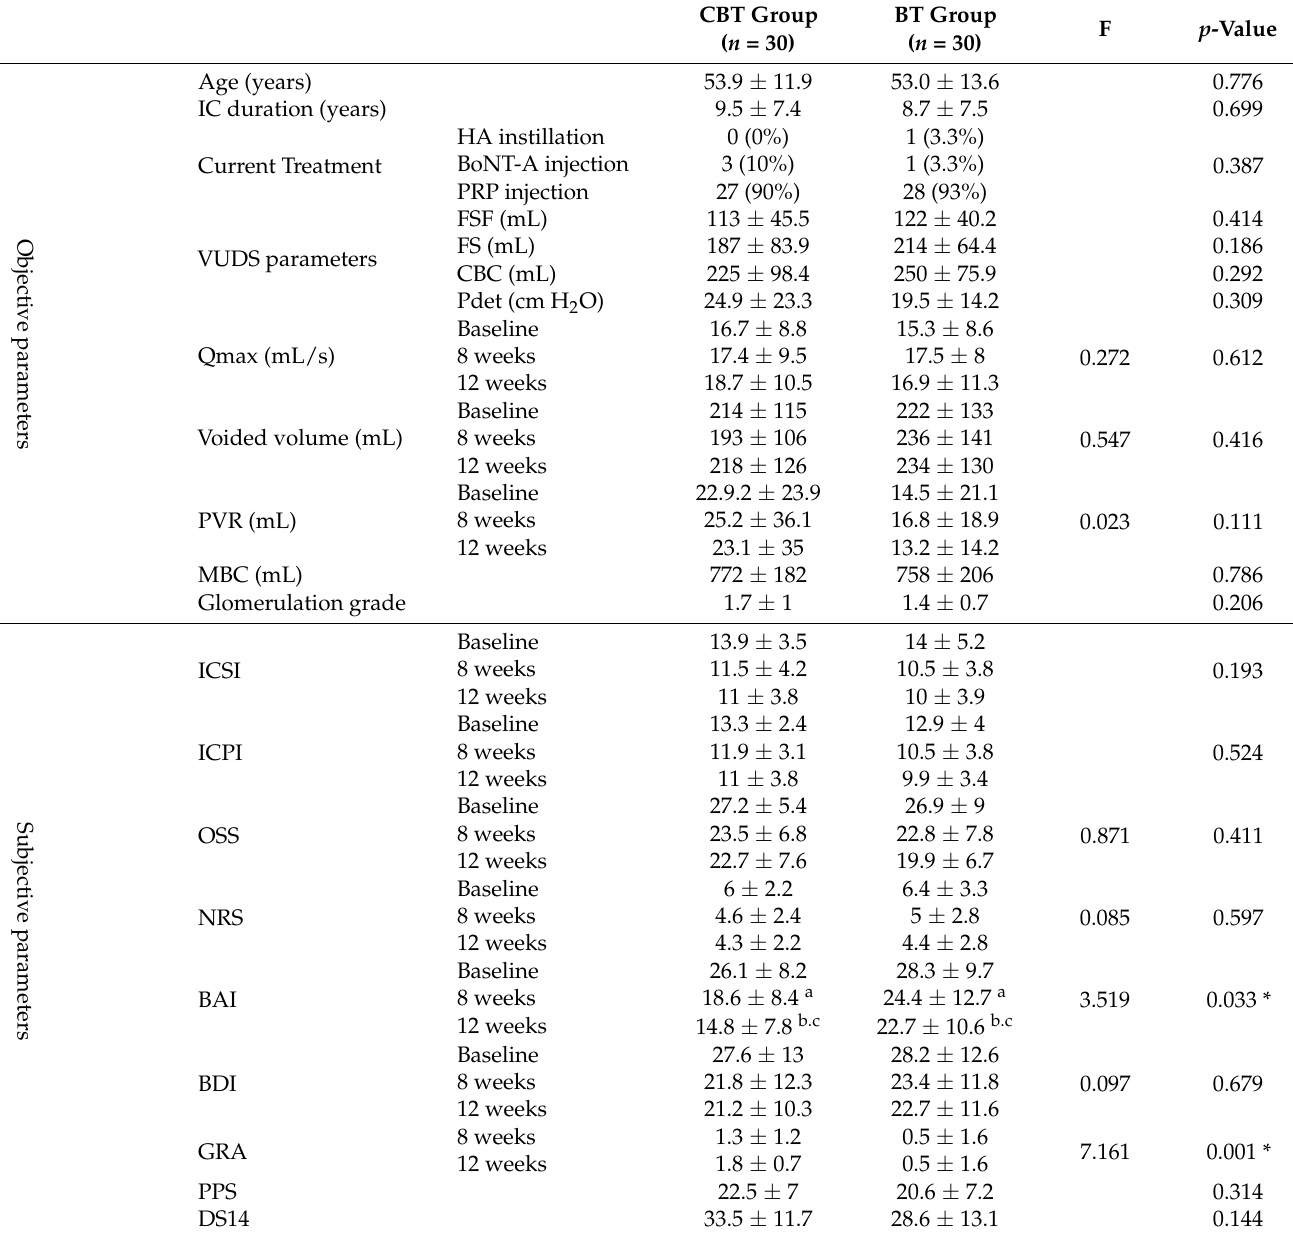
Table 2. Comparison of objective and subjective parameters between the CBT intervention and control groups pre- and post-intervention ( n =